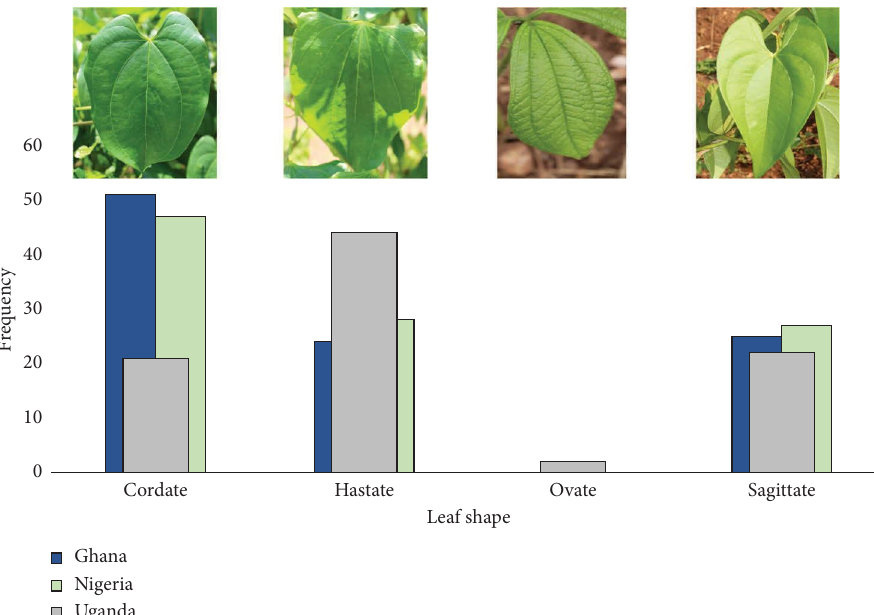
Figure 1: Phenotypic variability of plant morphology-based leaf shape and colour.